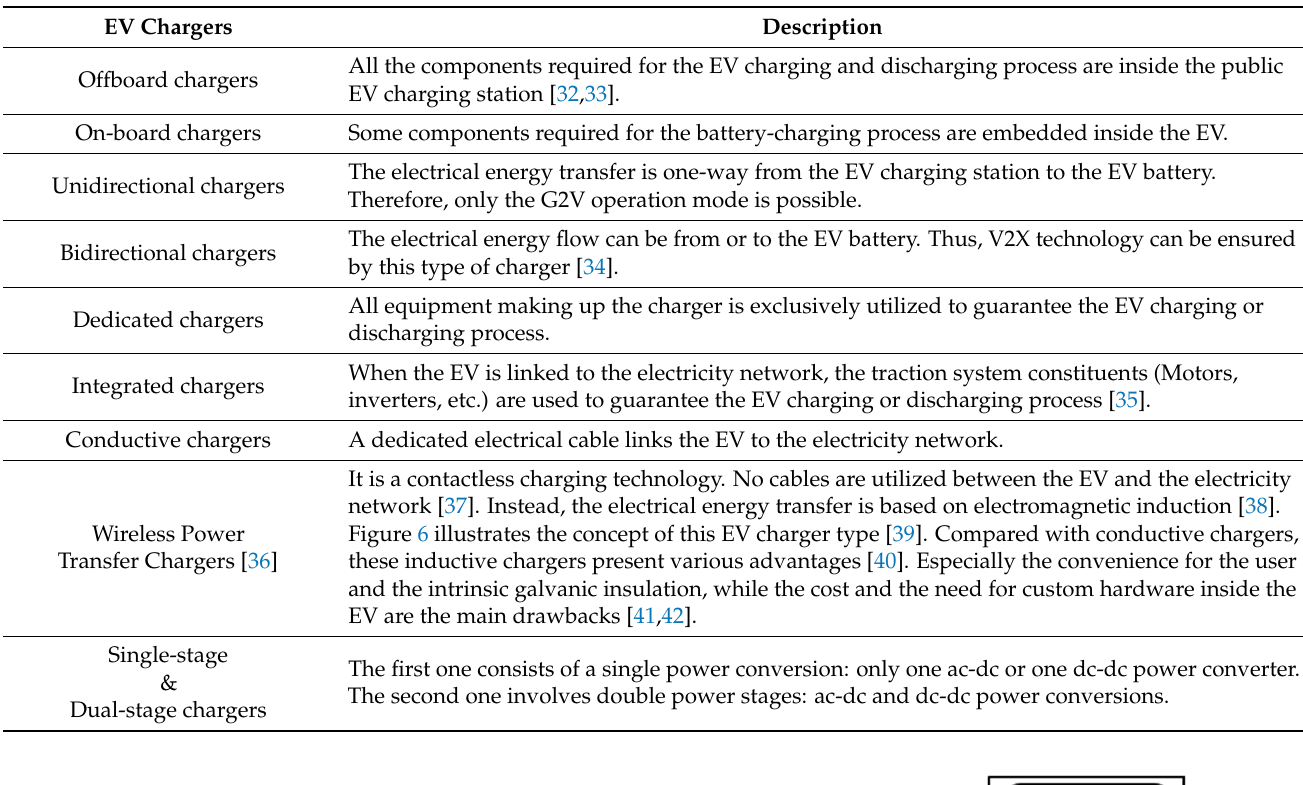
Table 1. EV charging systems classification.